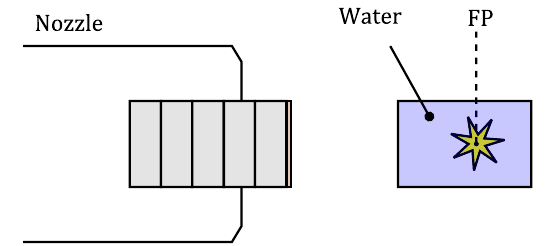
FIG. 11. Insertion of water slab at the focal point. The thick- ness of the water column is matched to the energy of the beam such that it always stops at the focal point.